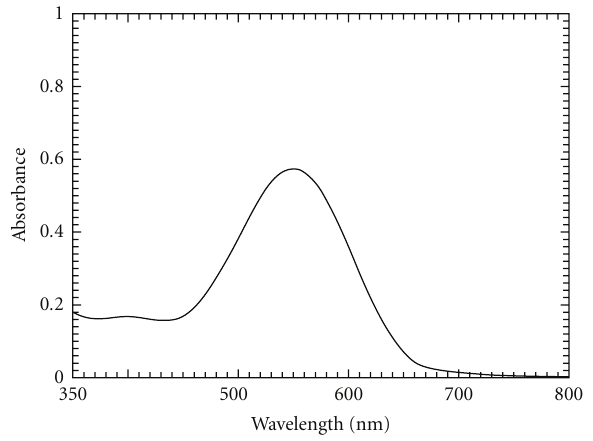
Figure 2: Absorbance spectrum of the colored product produced from the reaction of AHTT and 40 µ g mL − 1